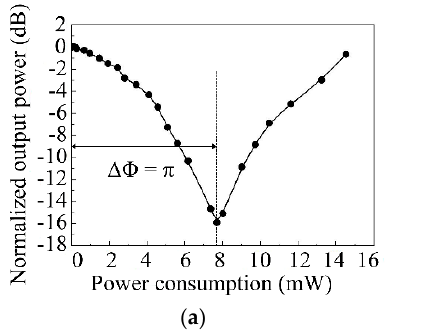
Figure 6. ( a ) Measured output power of the graphene-doped TO switch with di ff erent driving powers at a wavelength of 1550 nm, and ( b ) the response waveforms measured by an oscilloscope ( upper trace : input electric signal; lower trace : output optical power signal).